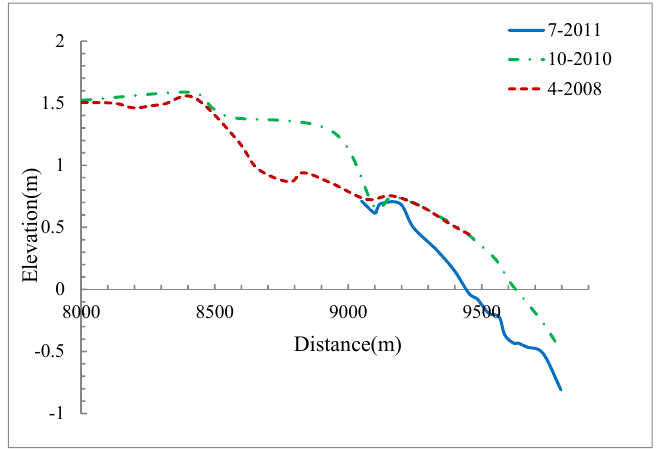
Figure 13. Rapid accretion-erosion transformation during October 2010–July 2011 (data are extracted from [15], with the datum shifting to MSL).